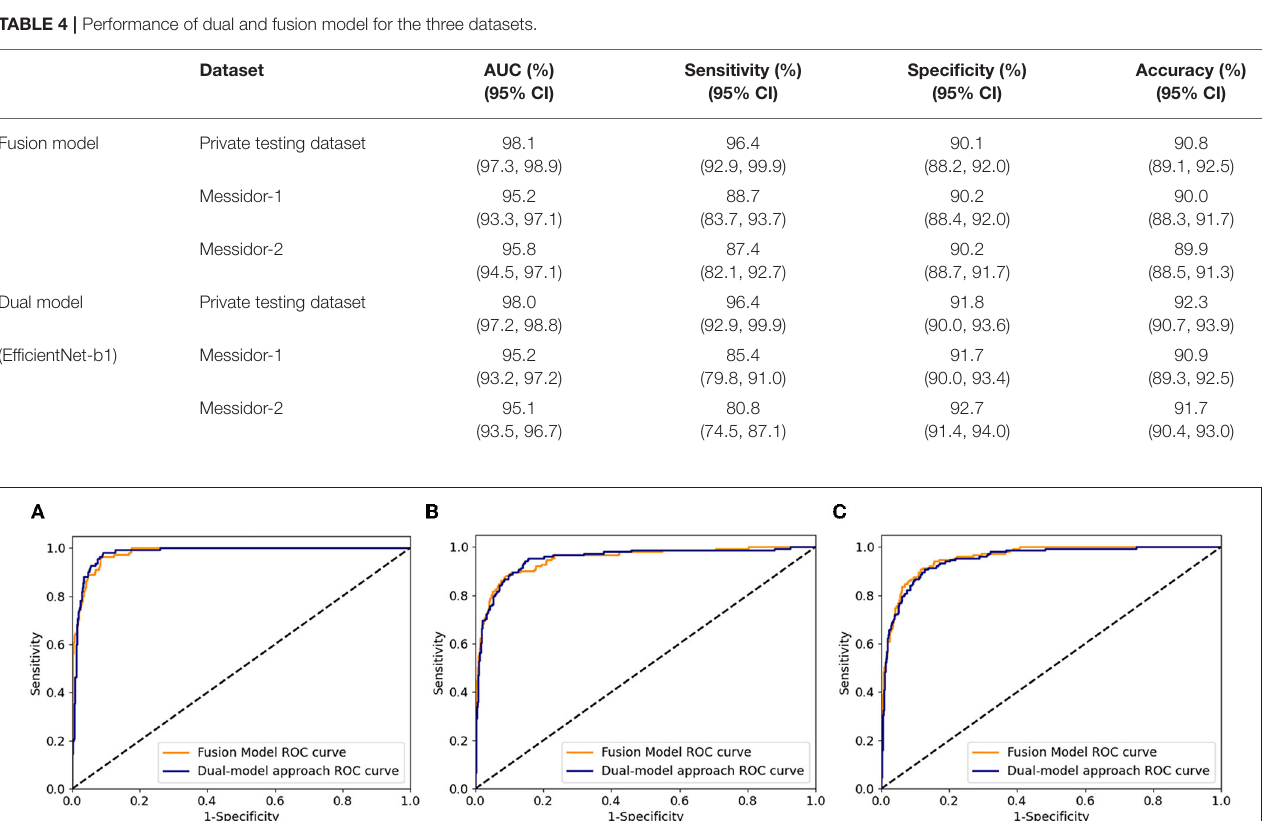
models by using true positive, false positive, true negative, and false negative to calculate the accuracy, sensitivity, and